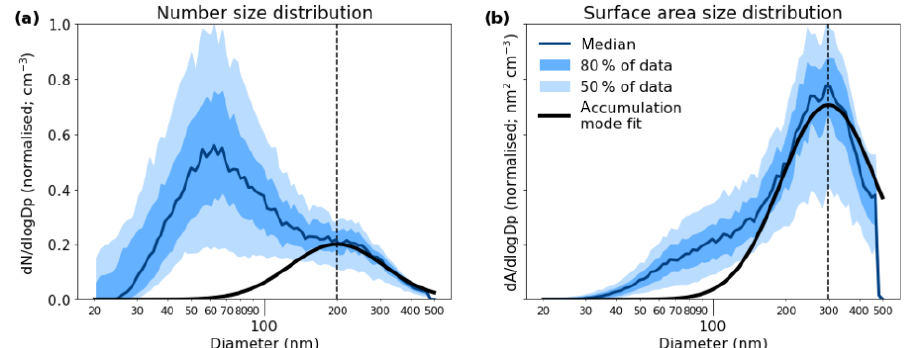
Figure 3. The (a) number size distribution and (b) volume size distribution of submicron aerosol below 2500m in the area outlined by the box in Fig. 1. The dark blue lines show the median size distributions; the darker shading represents data between the 25th and 75th percentiles (50% of the data) and the lighter shading data between the 10th and 90th percentiles (80% of the data). The thick black line represents a log-normal curve fitted to the accumulation mode. The rapid drop-off at the high end of the surface area distribution is an artefact of the SMPS size limit.